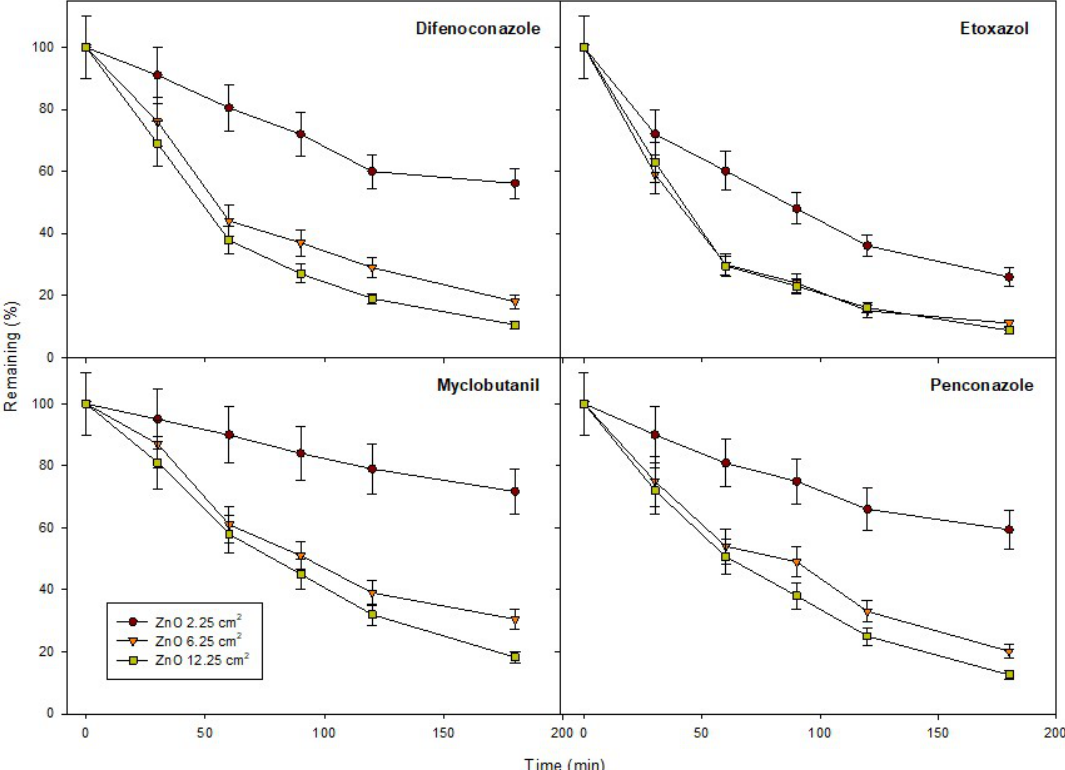
Figure 5. Optimization of ZnO load for photocatalytic degradation of the pesticides (0.1 mg L − 1 ). Error bars denote standard deviation (n = 3).